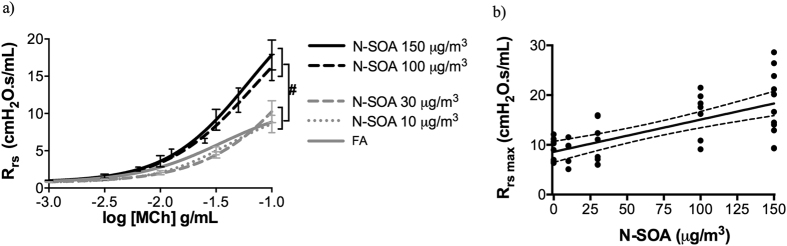
Healthy naïve BALB/c mice exhibit increased respiratory resistance to methacholine (MCh) following 3-day exposure to N-SOA.(a) The total lung resistance (Rrs) to methacholine shows a dose-response relationship to increasing concentrations of N-SOA with the methacholine dose-responsive curves for N-SOA 100 μg/m3 and N-SOA 150 μg/m3 (#p < 0.05, n = 6–11/group). (b) The maximum resistance (Rrs max) showed significant dose-responsive increased to progressively higher concentrations of N-SOA (p < 0.05, r = 0.627, Spearman correlation, n = 6–11/group).